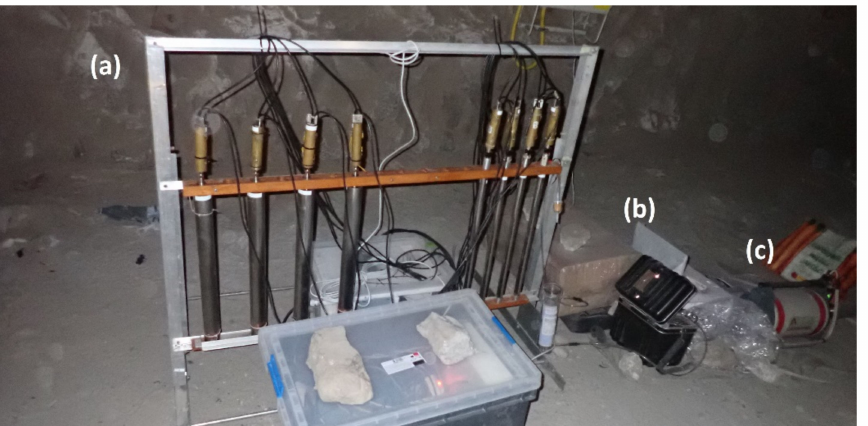
Figure 2. Measurement setup used during the measurements: ( a ) visible flat tray of helium counters placed vertically in the stand; visible Centronic (thicker) and ZDAJ (thinner) counters (at the base of the tray, as well as plastic boxes which are dustproof housing for DAQ (background one) and power suppliers (foreground one)); ( b ) radon monitor RAD7; ( c ) HPGe